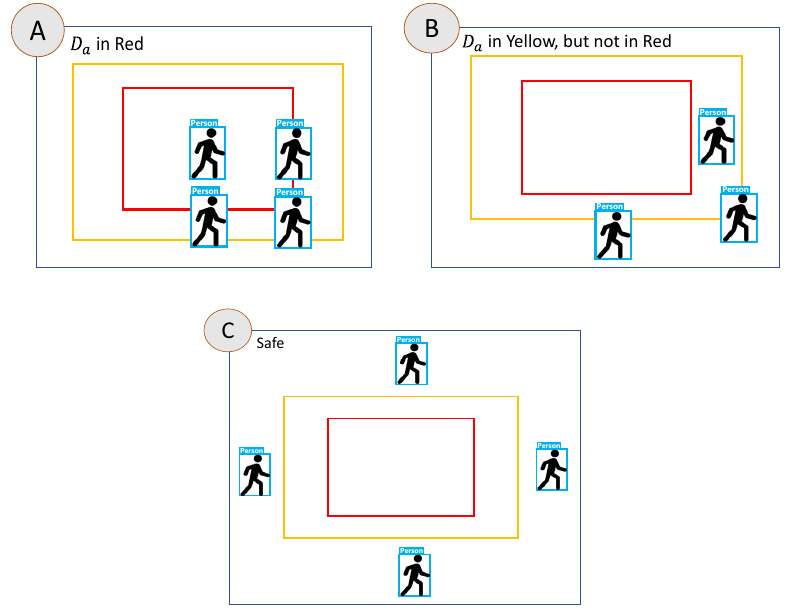
Figure 6. Case A, Case B and Case C.